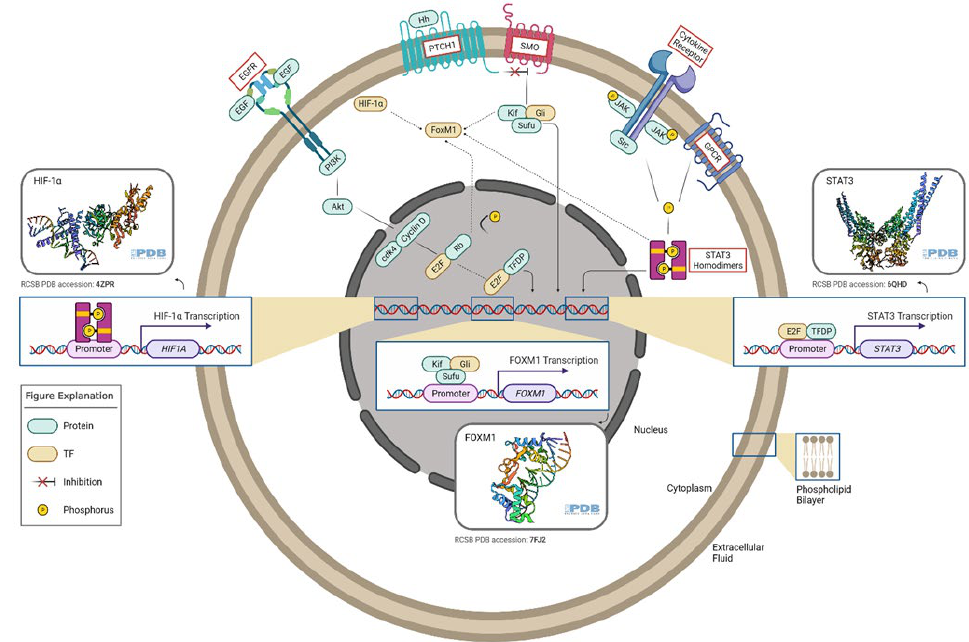
Figure 1. Oncogenic transcription factors and associated signaling pathways in gliomas. E2F TF is a downstream factor of the EGFR/PI3K/Akt pathway. The Rb tumor suppressor protein (pRb) binds to the E2F1 transcription factor, preventing it from interacting with the cell’s transcriptional machinery. When pRb gets phosphorylated, it detaches from E2F. E2F (along with its binding partner, TFDP) mediates the transactivation of E2F1 target genes, such as STAT3 . GLI TF is a downstream effector of the Hedgehog pathway. In the absence of Hh, PTCH acts to prevent high expression and activity of SMO. GLI TFs function in a complex with Kif7 and Sufu, translocate to the nucleus, and induce the expression of target genes such as FoxM1. STAT3 TFs can be activated by several signals, which involve G-protein-coupled (GPCR) and cytokine receptors. Phosphorylated STAT3 homodimers regulate HIF- 1α expression. FoxM1 can be activated by STAT3, GLI, HIF - 1α , and E2F TFs. This figure was created with the tools provided by BioRender.com, accessed on 22 February 2022.